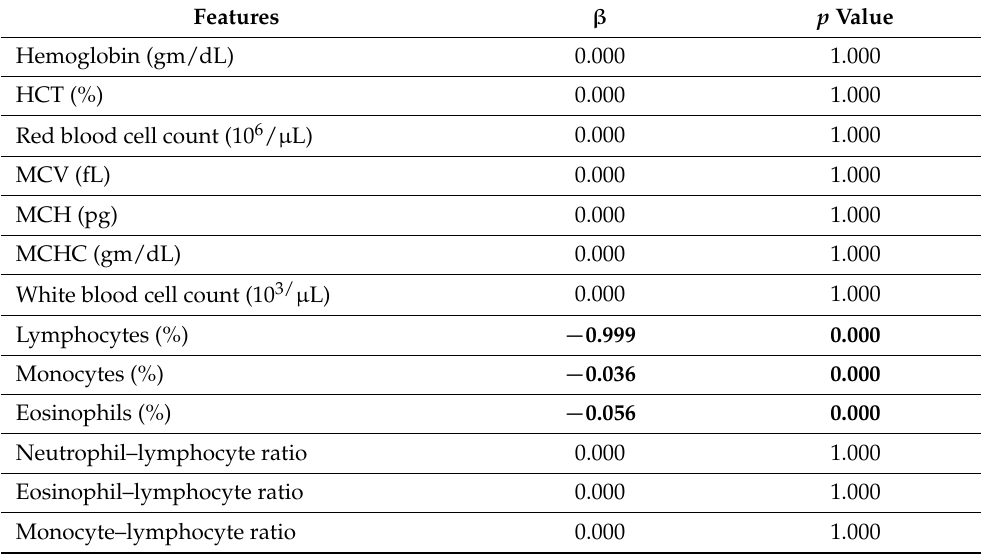
Table 3. Multi-linear regression analysis for neutrophil count towards polycystic ovary